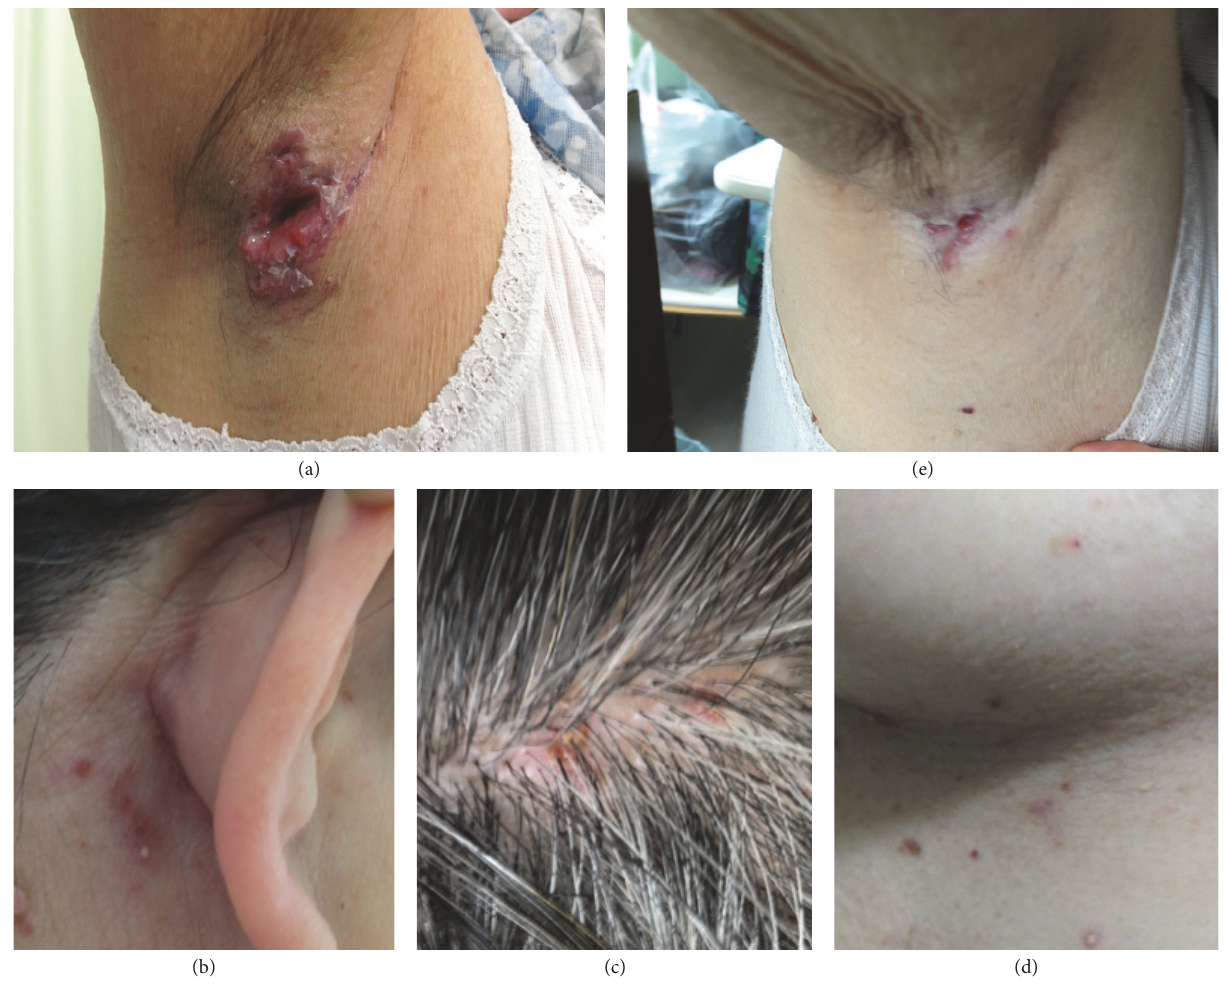
Figure 1: Photos of pretreatment right-axillary ulcer (a); cutaneous eruptions of LCH at the retroauricular area (b), scalp (c), and under the breast (d); posttreatment (after 4.5 months of imiquimod) status at the right axilla